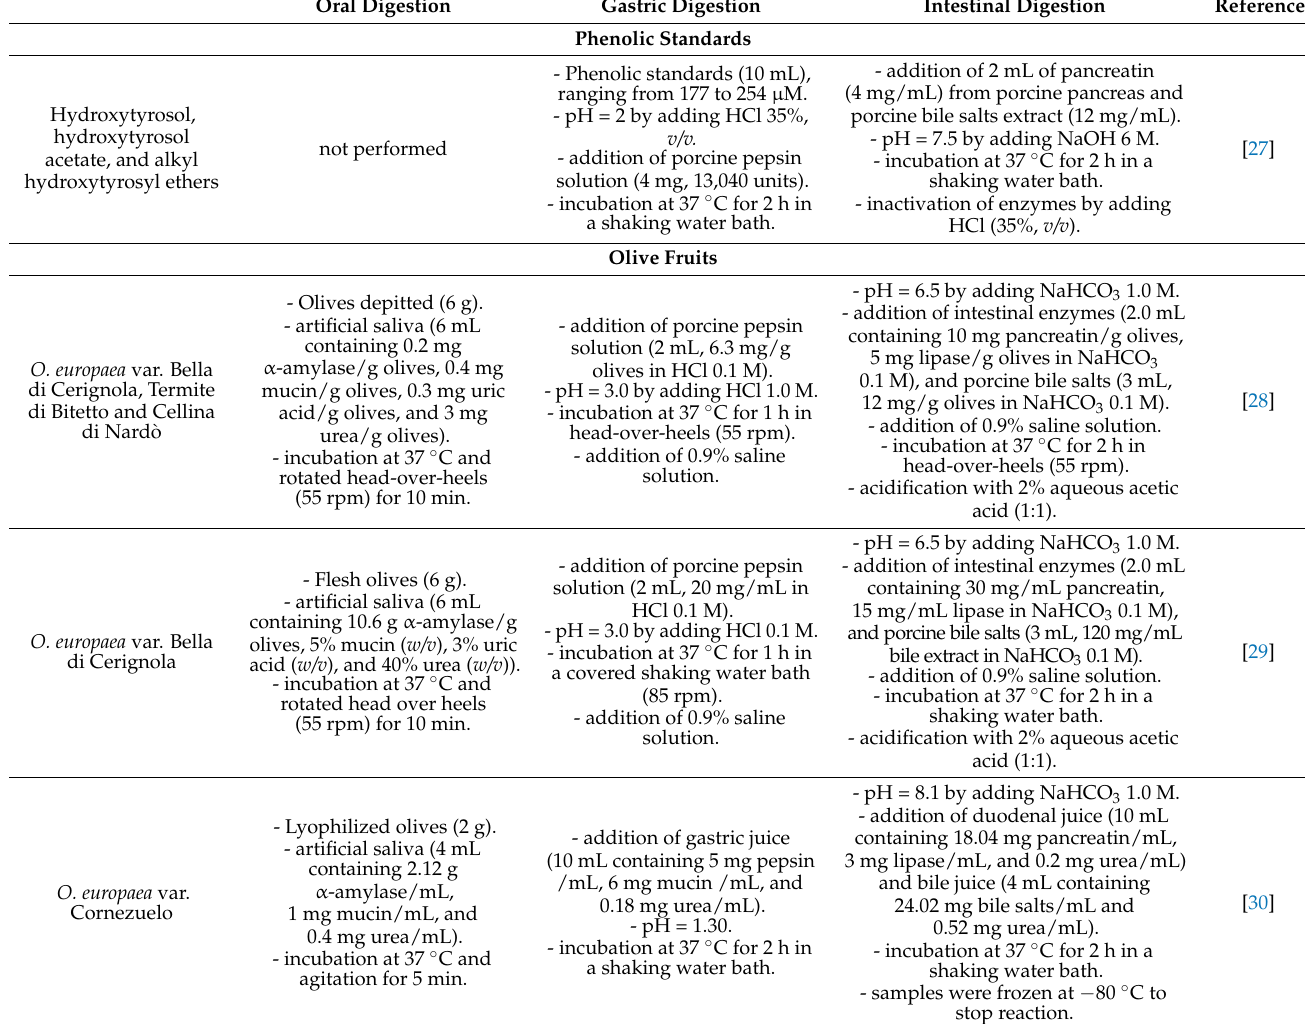
Table 1. Experimental conditions of simulated gastrointestinal digestion applied to different olive matrices for the assessment of